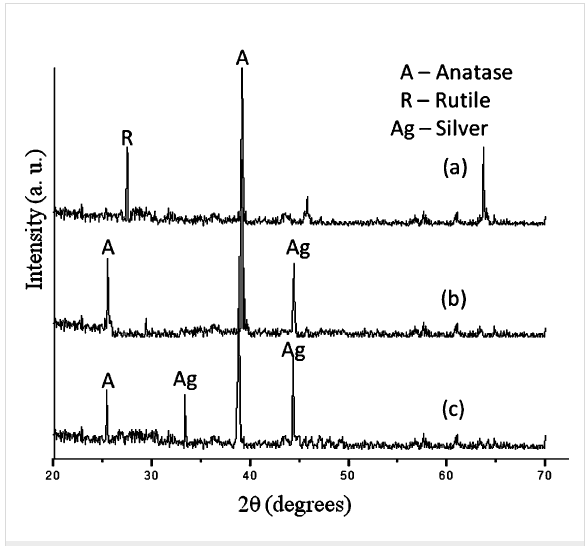
Figure 1: XRD pattern of (a) TiO 2 and (b) 3% and (c) 7% Ag-doped TiO 2 nanoparticles annealed at 450